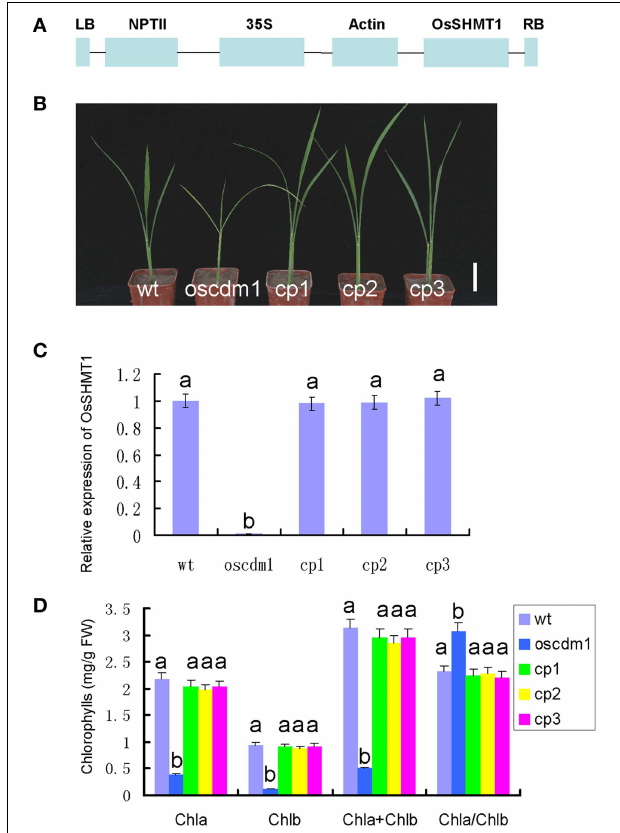
FIGURE 5 | Complemented expression of OsSHMT1 rescued the mutant phenotypes of oscdm1 . (A) Schematic structure of the actin-OsSHMT1 complementation vector. NPTII was used as a marker in the transformation test. (B) Complementation of the oscdm1 mutant by the wild-type gene. Japonica rice oscdm1 callus was used for transformation (see the “Materials and Methods”). Images of the wild-type plants, oscdm1 mutant plants, and independent complemented plants (cp)1, cp2, and cp3 were taken after 1 month. Bar = 2cm. (C) qRT-PCR analyses of OsSHMT1 expression in wildtype, oscdm1 ,andincp1,cp2,andcp3showedthattheexpressionlevelin cp1, cp2, and cp3 was near the wild-type level. The experiments are biological replicates with the SD. (D) The leaf pigment contents in wild type, oscdm1 , and in cp1, cp2, and cp3 were measured. The pigment contents of the complemented lines were rescued to the wild-type level. Data were compared by one-way analysis of variance and Duncan’s multiple range test. Different letters (a–b) indicate significant differences (P, 0.05) between